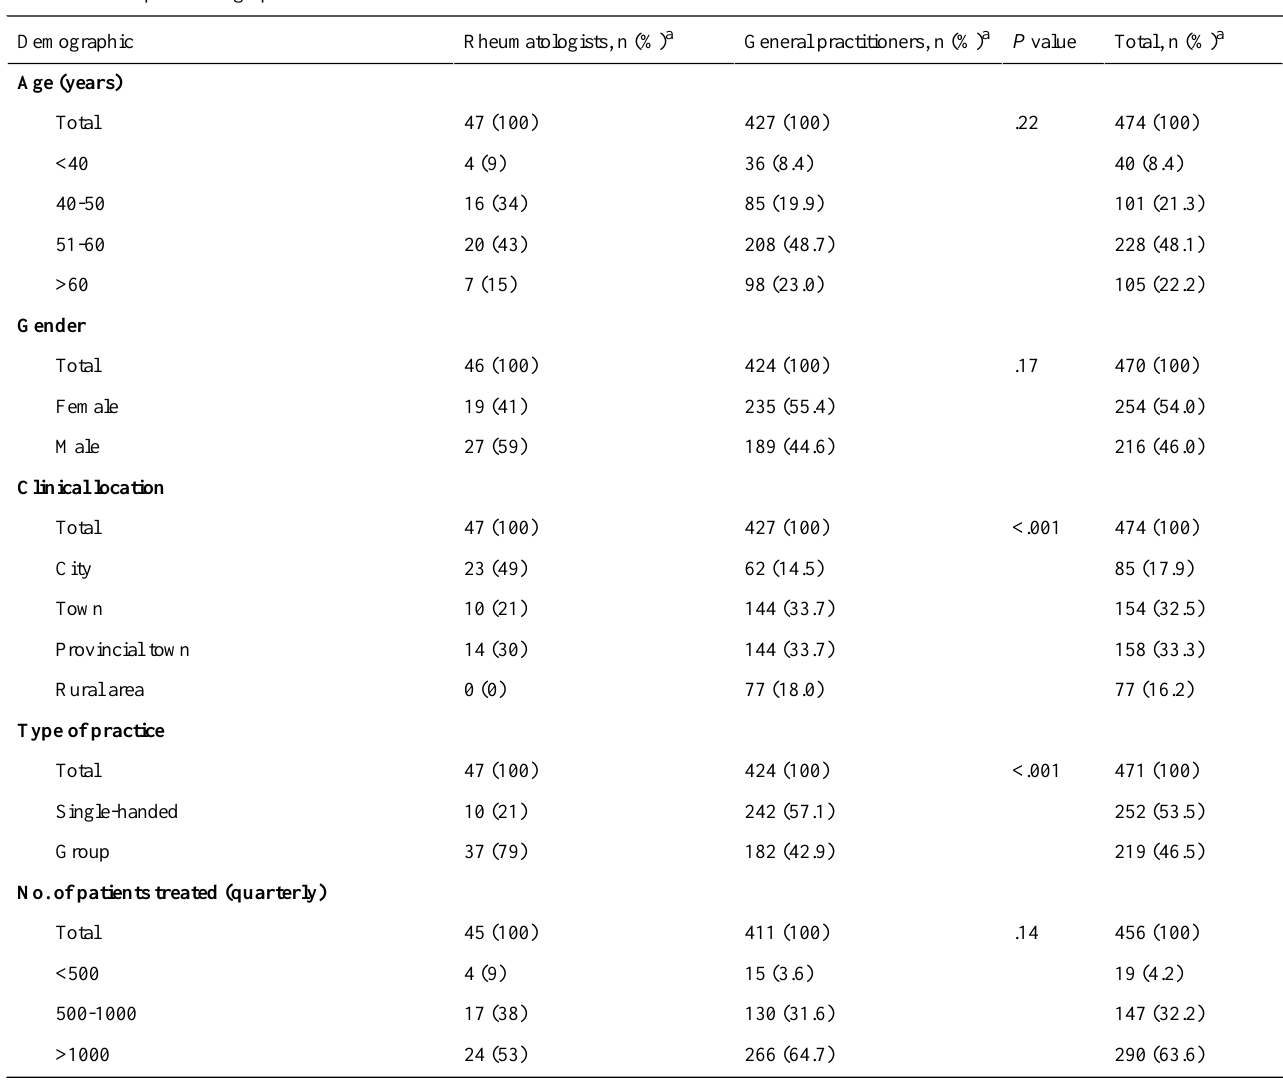
Table 1. Participant